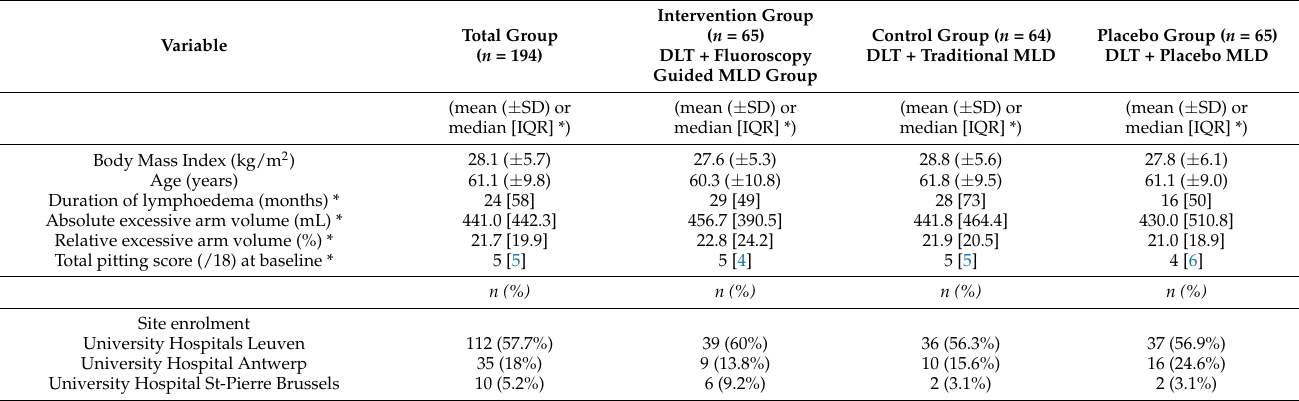
Figure 2. Overview of the study flow (DLT = decongestive lymphatic therapy; MLD = manual lymph drainage; B0 = baseline; P = post-intensive phase; P6 = after 6 months of maintenance phase). Table 3. Characteristics of the participants.